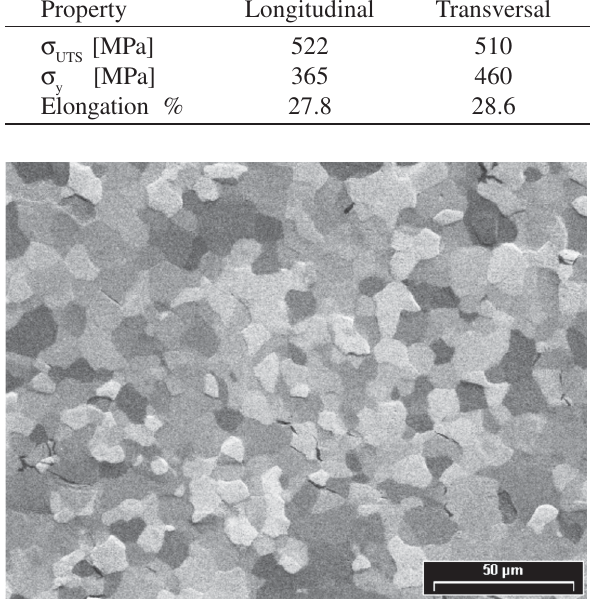
Figure 1. SEM micrograph showing the Zircaloy-4 microstruc-